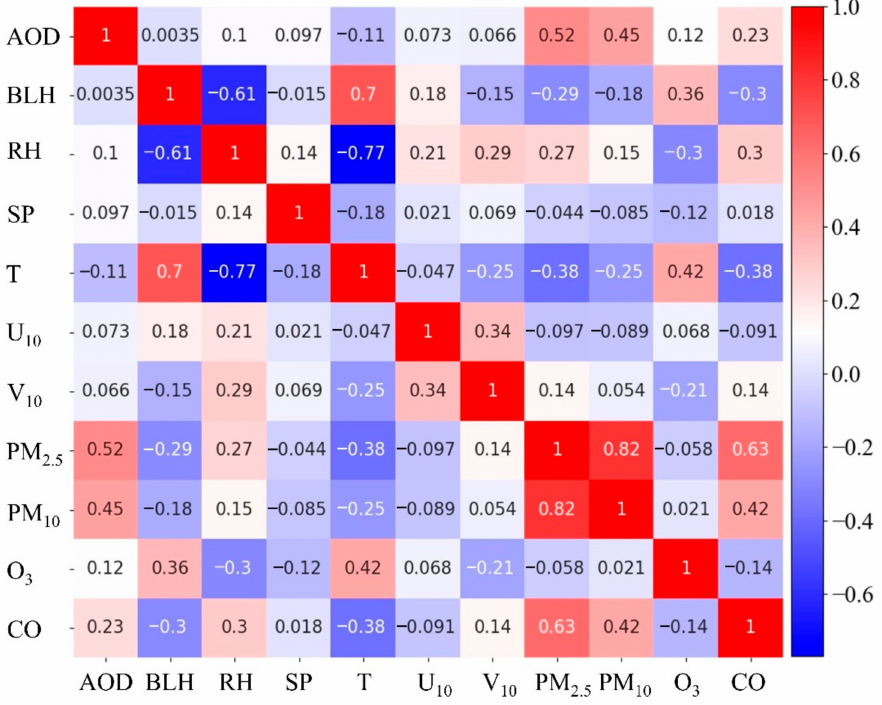
Figure 2. The correlative analysis between input and output